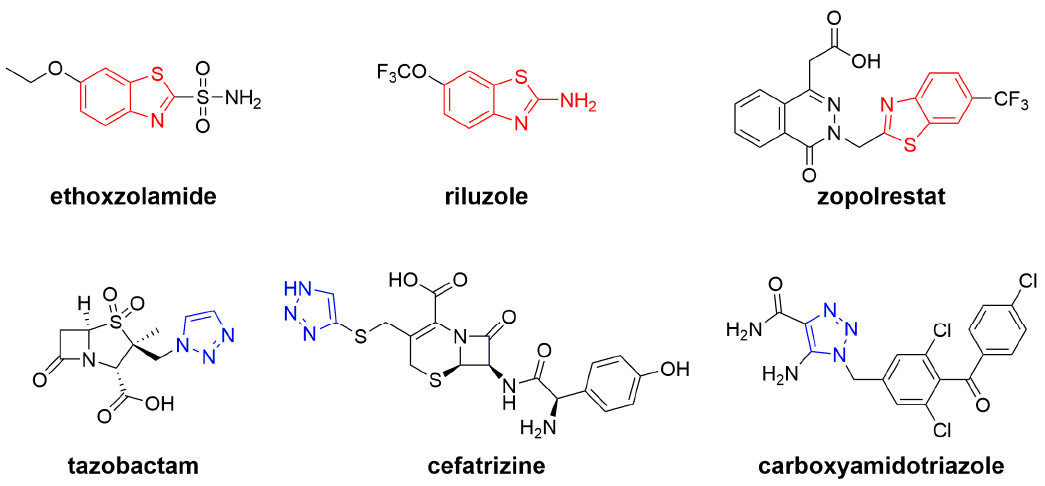
Figure 1. The structures of some commercial drugs containing benzothiazole or 1,2,3-triazole moiety.